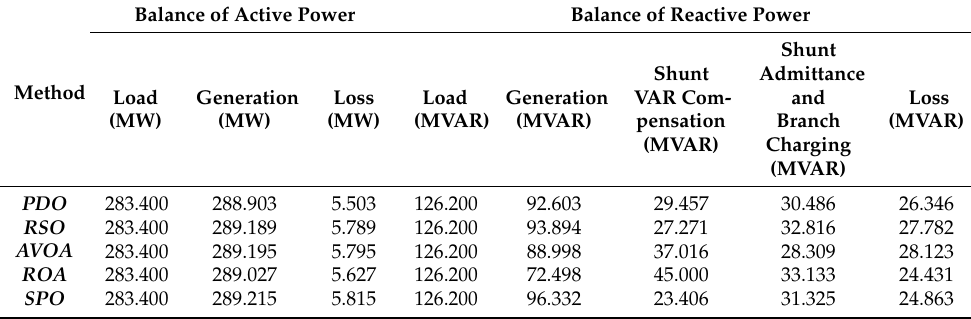
Table 7. Balance of active and reactive power for proposed algorithms with case 1.